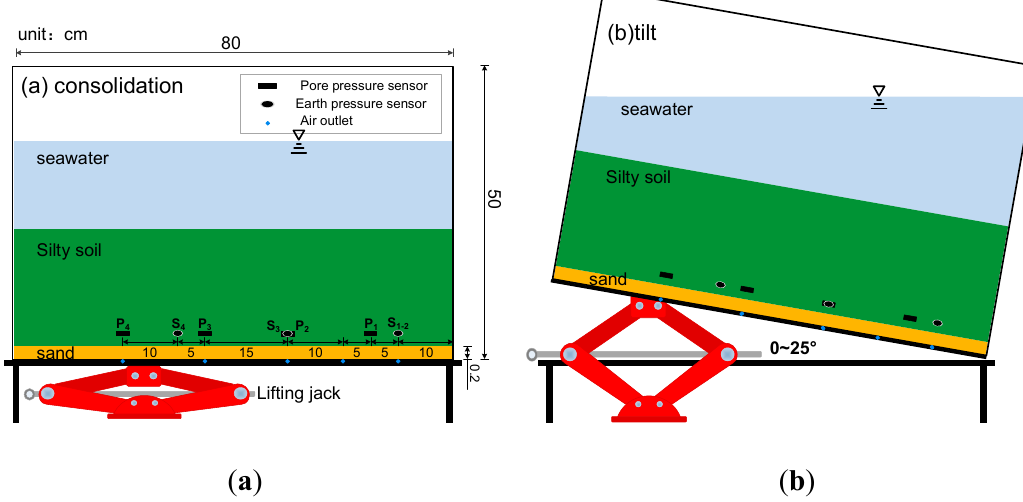
Figure 6. Schematic diagram of sedimentary soil sample preparation. (a) consolidation; (b) tilt.